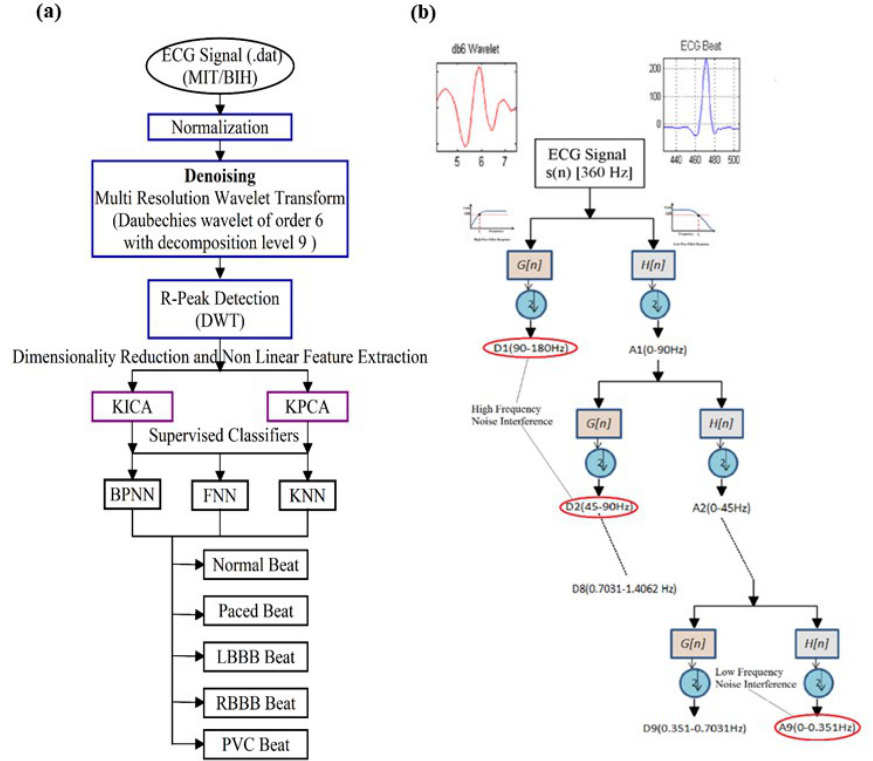
Figure 1 . (a) Proposed scheme (b) DWT decomposition tree showing multiresolution characteristics for